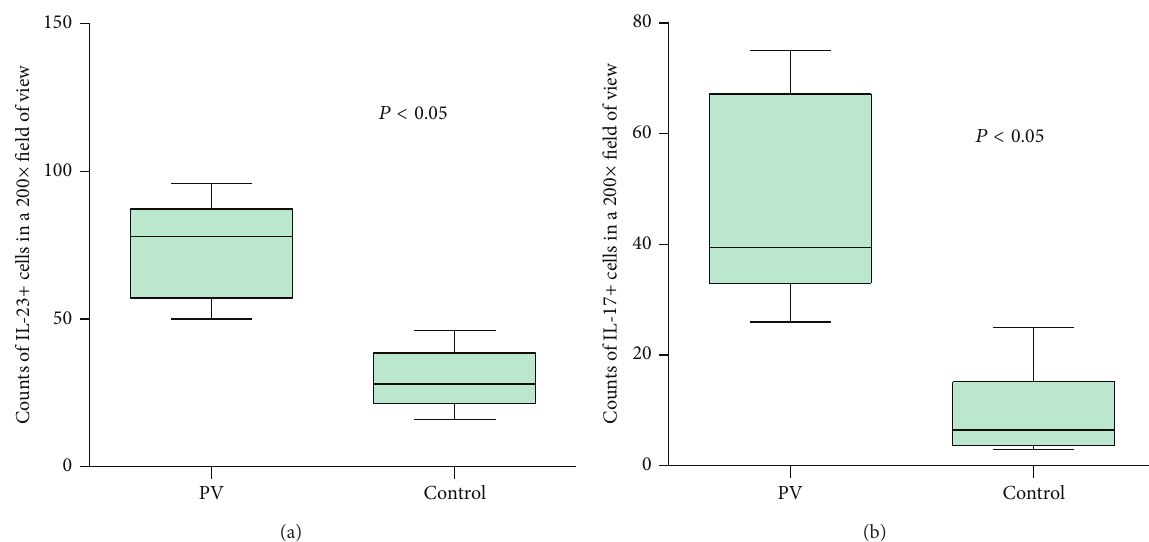
Figure 3: Quantification of the number of IL-23+ cells (a) and IL-17+ cells (b) in PV and normal control group. The significance of the differences was assessed by an unpaired t -test.